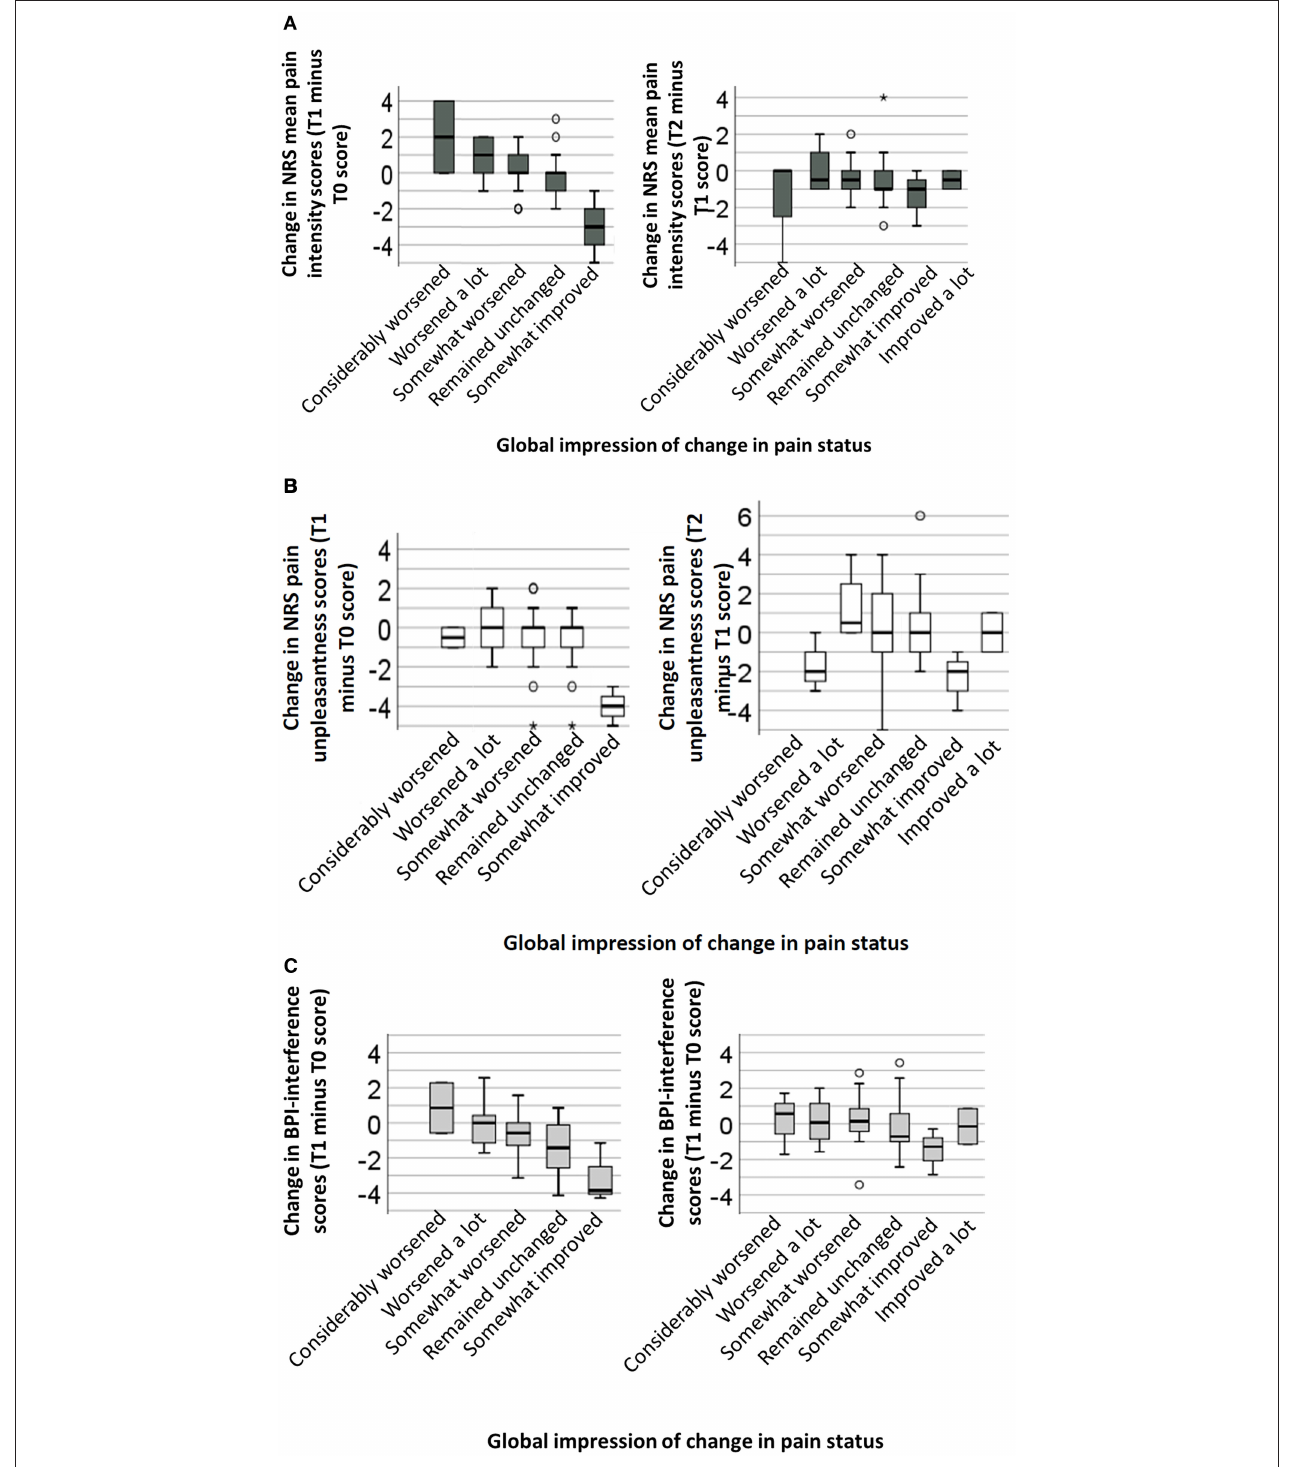
FIGURE 2 | Box plots of pain changes between the first wave of the pandemic (T1) and pre-pandemic pain levels (left graph) and between the end of the first wave (T2) and during the first wave (T1) of the pandemic (right graph). Row (A) represents changes in pain intensity scores, row (B) represents changes in pain unpleasantness scores, and row (C) represents changes in pain interference scores. Each box represents the first (Q1) and third (Q3) quartile and the middle line represent the median. The whiskers represent the minimum and maximum (Q1 or Q3–1.5*interquartile range) of the score distribution, with circles representing outliers. A score above zero on the y-axis indicates an increase in pain/interference scores (i.e., pain deterioration) from baseline to T1 (left graph) or from T1 to T2 (right graph), while a score below zero on the y-axis represents a decrease in pain/interference (i.e., pain relief). The x-axis represents individuals’ global impression of change in pain status.